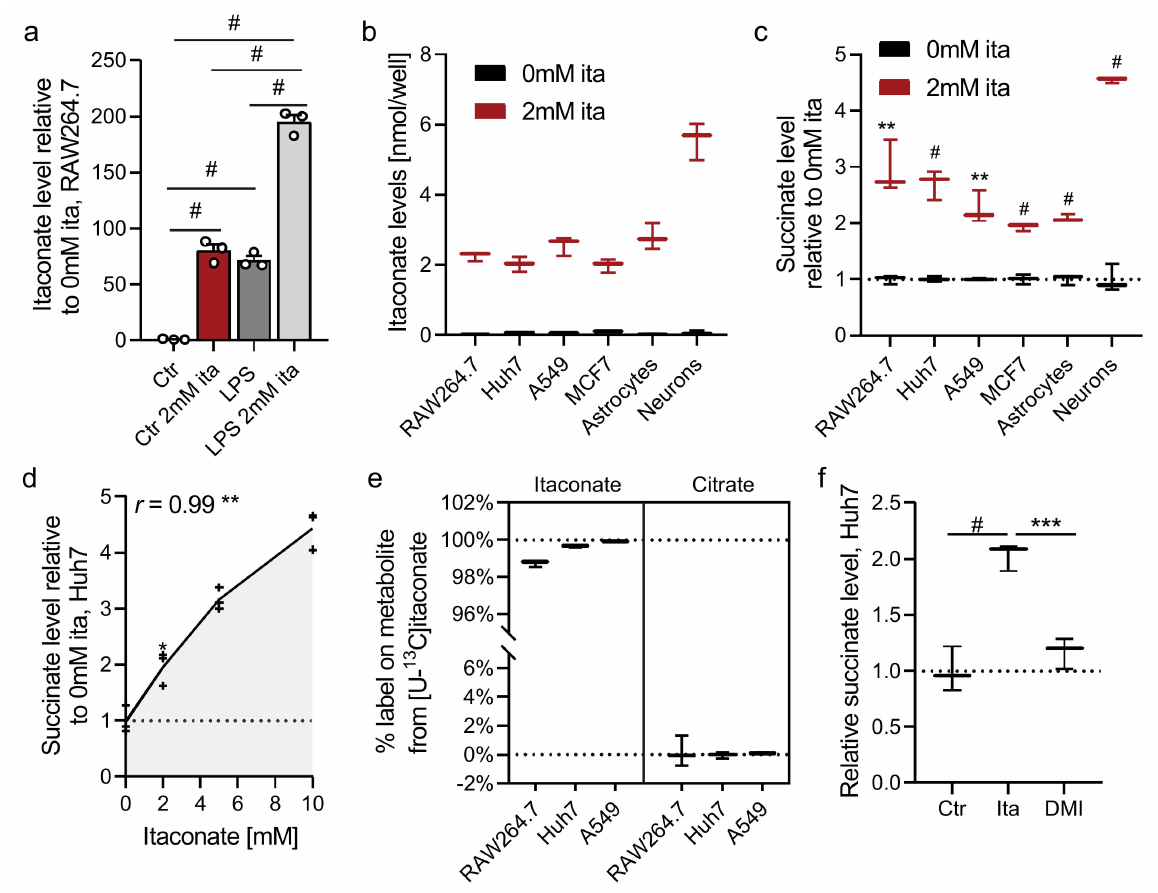
Figure 1. Itaconate promotes succinate accumulation in diverse cell types. ( a ) Itaconate levels in RAW264.7 cells exposed to LPS or 2 mM exogenous itaconate (ita) for 24 h compared to control condition (Ctr). ( b , c ) Itaconate ( b ) and succinate ( c ) levels in cells exposed to 2 mM itaconate for 48 h. ( d ) Pearson correlation coefficient ( r ) of itaconate and succinate levels in Huh7 cells exposed to increasing itaconate concentrations for 48 h. ( e ) Labeling on itaconate and succinate in cell lines cultured in the presence of 2 mM [U- 13 C 5 ]itaconate. ( f ) Succinate levels in Huh7 cells exposed to 2 mM itaconate or 62.5 µ M dimethyl-itaconate (DMI) for 48 h. Data are depicted as box and whiskers ( b , c , e , f ) or mean ( d ) ± s.e.m. ( a ) obtained from 3 cellular replicates. Students t -test ( c ) or one-way ANOVA ( a , f ) with no adjustment for multiple comparisons. * p < 0.05, ** p < 0.01, *** p < 0.001, # p <